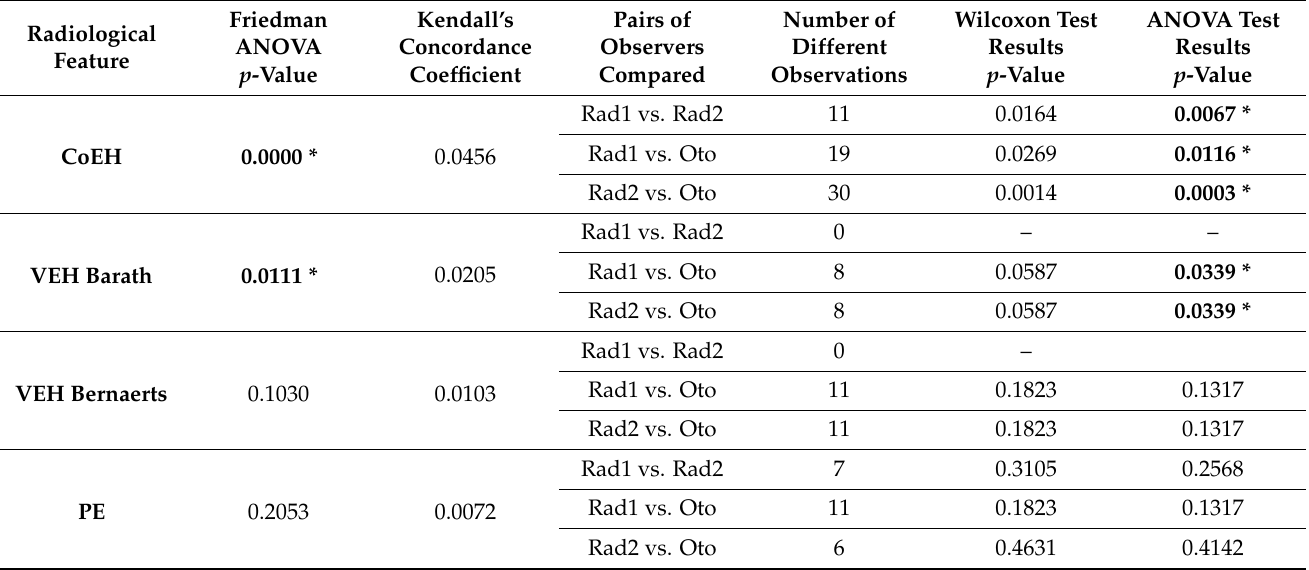
Figure 4. Stacked bar chart presenting differences of cochlear endolymphatic hydrops grading, vestibular endolymphatic hydrops grading on Barath scale, vestibular endolymphatic hydrops grading on Bernaerts modification, and perilymphatic enhancement assessment in each group of analyzed ears (definite Ménière’s, probable Ménière’s, ears with Menieriform symptoms, asymptomatic ears) performed by three observers (two radiologists and one otorhinolaryngologist in training; Rad1, Rad2, and Oto, respectively). Table 2. Statistical dependencies ( p -values) of ANOVA Friedman test, Kendall’s concordance coefficient, and Wilcoxon signed-rank test—evaluation of each analyzed MRI hydrops feature differences across three observers (two experienced radiologists and otorhinolaryngologist in training) to assess inter-judge reliability.